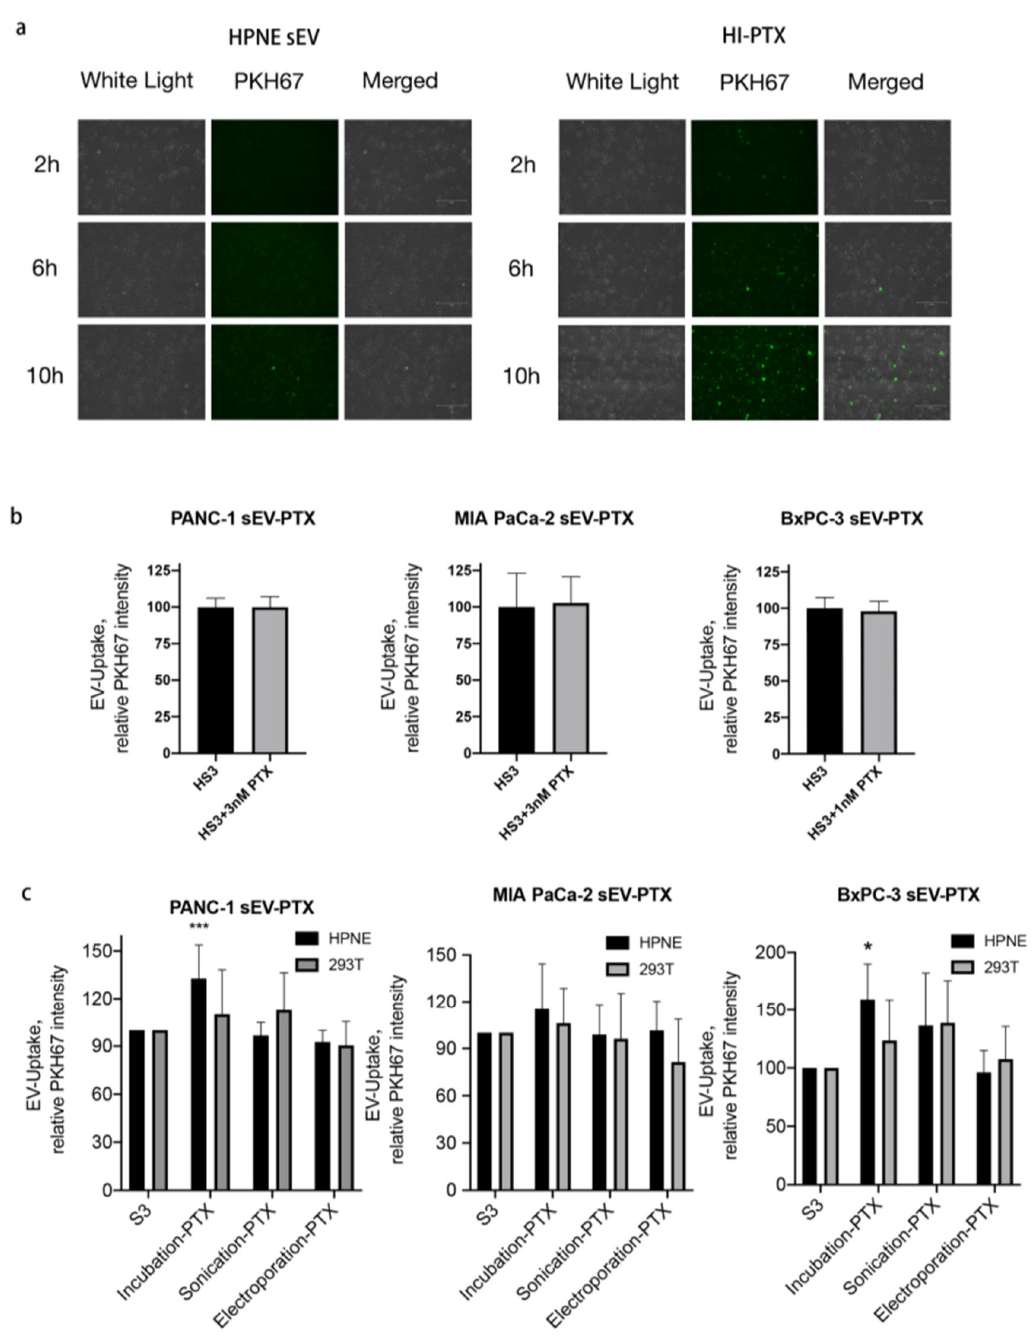
Figure 3. HI ‐ PTX is taken up more effectively by pancreatic cancer cells. ( a ) Equal amounts of HPNE ‐ sEV and HI ‐ PTX were labeled with PKH67 and loaded onto PANC ‐ 1 cells for 2 to 10 h. Cellular uptake of HPNE ‐ sEV and HI ‐ PTX was monitored by fluorescent microscopy (excitation 488 nm, detection, 510 nm; Nikon TE2000 ‐ E, 10× magnification); ( b ) Adding HPNE ‐ sEV and PTX simultaneously to PANC ‐ 1, MIA PaCa ‐ 2, and BxPC ‐ 3 cells did not enhance EV uptake. The fluorescence was detected by fluorescent microscopy and the fluorescence intensity was semi quantified, and presented as relative levels; ( c ) The uptake of HPNE ‐ and 293T ‐ derived EV, when loaded with PTX by incubation, sonication and electroporation, in the three pancreatic cancer cell lines. *** p < 0.001, * p < 0.05, one ‐ way ANOVA followed by Dunnett’s post ‐ test (data from three individual determina ‐ tions).